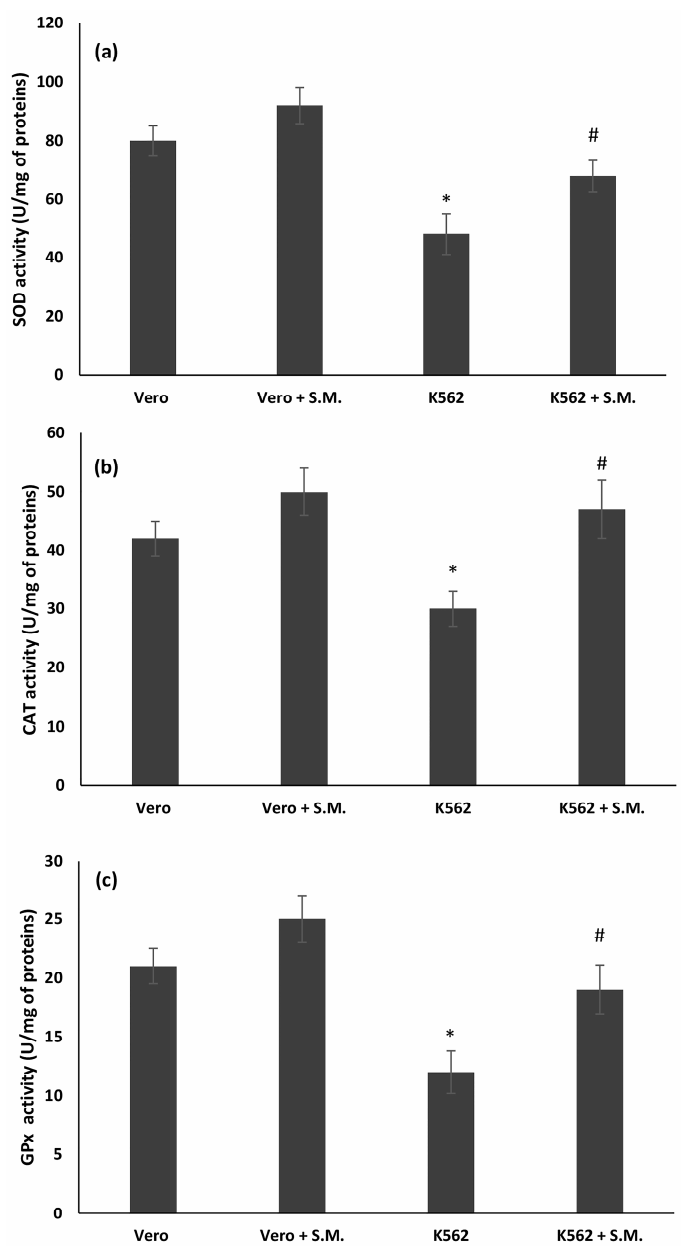
Figure 5. Effects of Skeletonema marinoi (S.M.) on ( a ) superoxide dismutase (SOD), ( b ) catalase (CAT), and ( c ) glutathione peroxidase (GPx) activities expressed as units for milligrams mg of proteins (U/mg of proteins) in Vero and K562 cells after 48 h incubation with S.M. extract (0.75 mg/mL). Data were represented by the means ± standard deviation (SD) of three experiments (* p < 0.05 means a significant difference between the Vero and K562 cells; # p < 0.05 means a significant difference between the treated and untreated K562